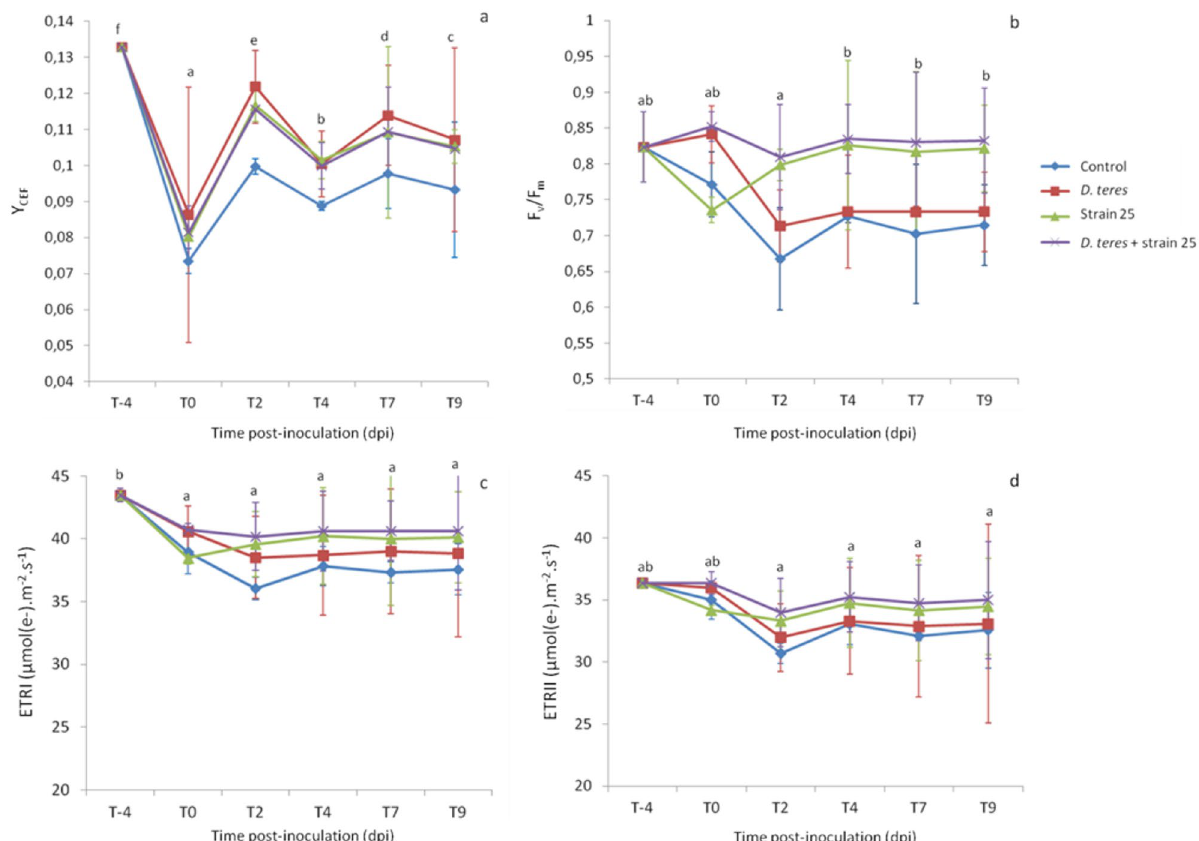
Figure 4. Changes in ( a ) quantum yield of cyclic electron flow (Y CEF ), ( b ) quantum yield of linear electron flow or maximum efficiency of PSII photochemistry (F v /F m ), ( c ) electron transport rate at PSI reaction centers (ETRI) and ( d ) electron transport rate at PSII reaction centers (ETRII) in the first barley leaf at 4 day before inoculation (T-4) with D. teres and 0, 2, 4, 7 and 9 dpi noted T2, T4, T7 and T9, respectively. The mean ± SE was calculated from three independent experiments for each experimental condition and for each time-point, n = 15. Different letters indicate statistically different means (Student’s test; p value < 0.05) between times